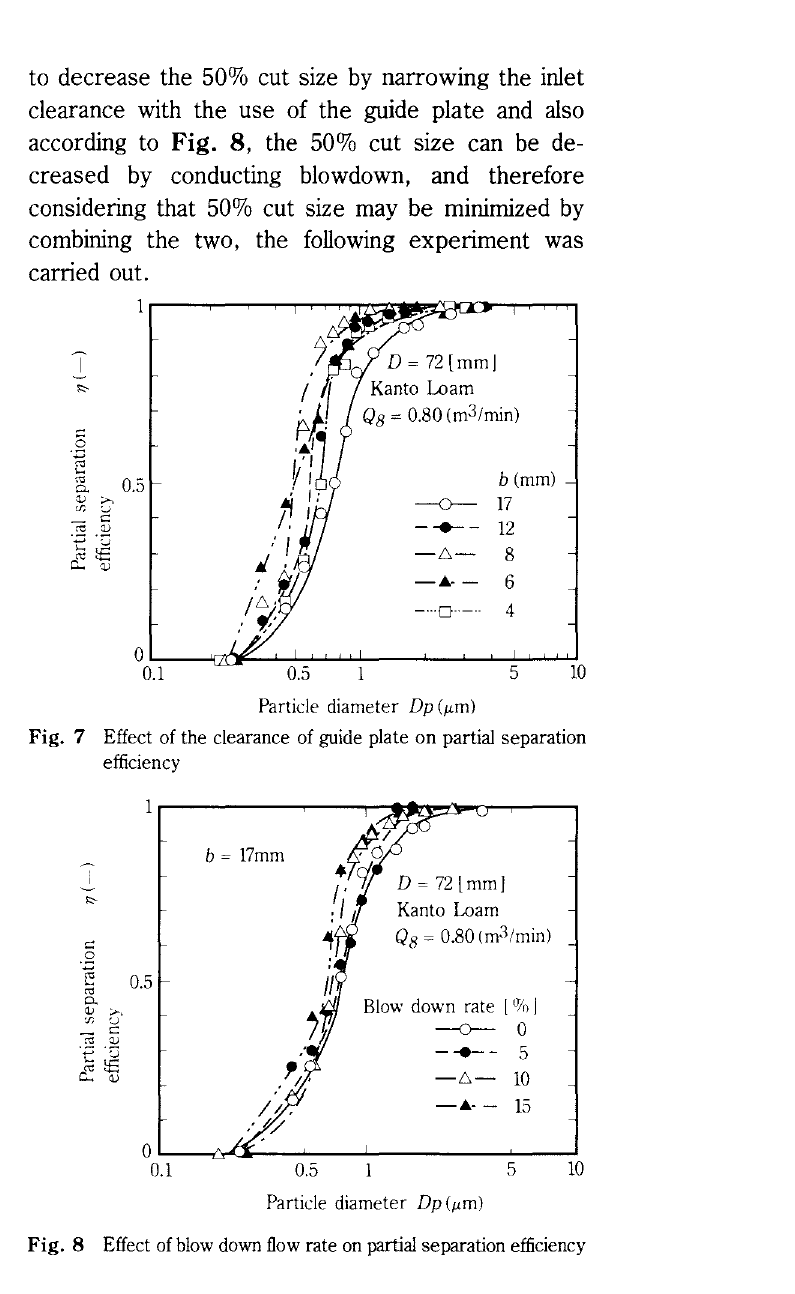
Fig. 8 Effect of blow down flow rate on partial separation efficiency Fig. 9 shows the experimental results